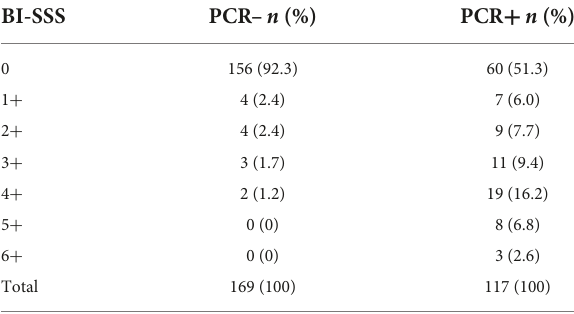
TABLE 4 Comparison between PCR and bacillary load results in HDP.